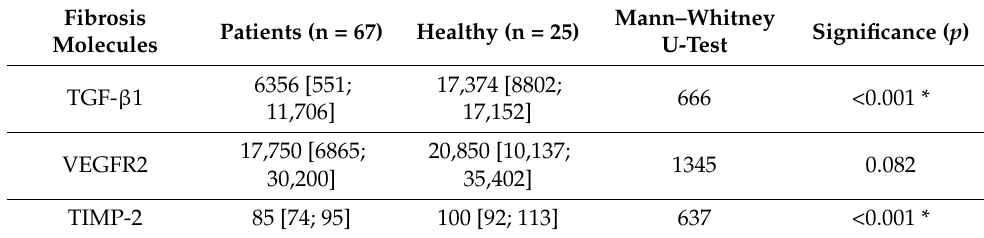
Table 4. Fibrosis molecules in the serum of patients following breast cancer treatment and healthy volunteers,